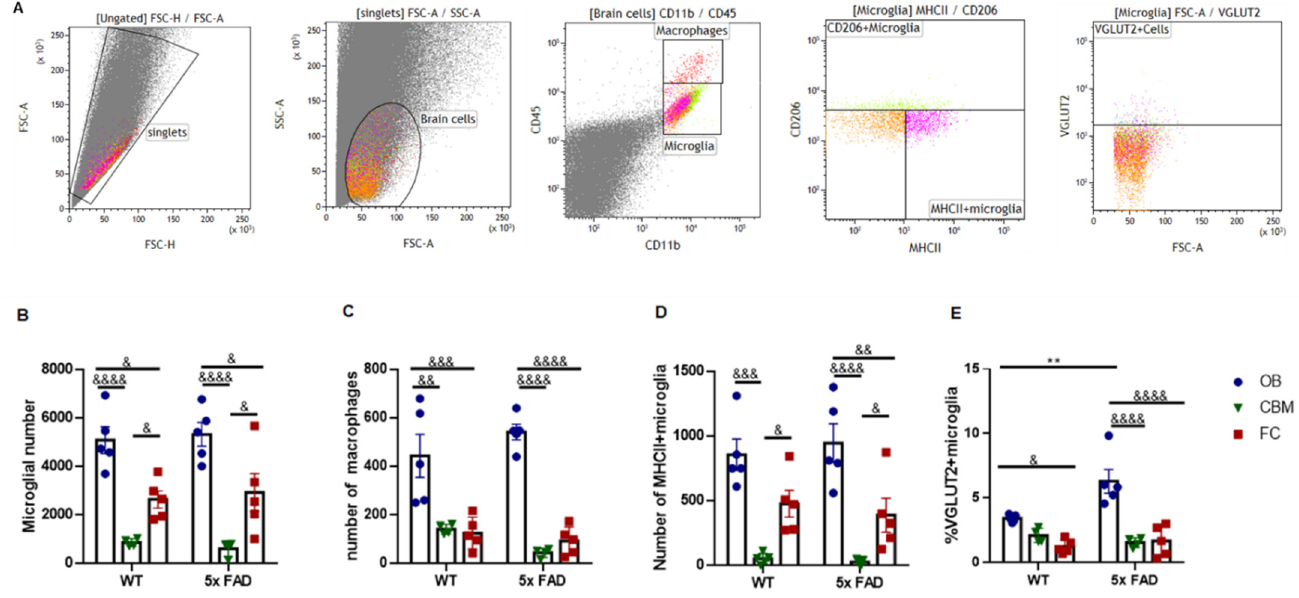
Figure 6. OB microglia showed increased VGLUT2 phagocytosis in 5~6 mo FAD male mice. ( A ) Representative graphs showing gating strategy for microglia, macrophages, and VGLUT2+ microglia. Numbers of microglia ( B ), macrophages ( C ), and MHCII+ microglia ( D ) among normalized total brain cells and percentage of VGLUT2+ microglia among total microglia ( E ) in different brain regions were quantitated. OB microglia were more abundant than other regional counterparts and showed enhanced VGLUT2 phagocytosis in 5×FAD mice compared to WTs. * symbolizes significant genotypic difference while & regional difference. ** p < 0.01, & p < 0.05, && p < 0.01, &&& p < 0.001, &&&& p < 0.0001 (two-way ANOVA with Tukey’s test).